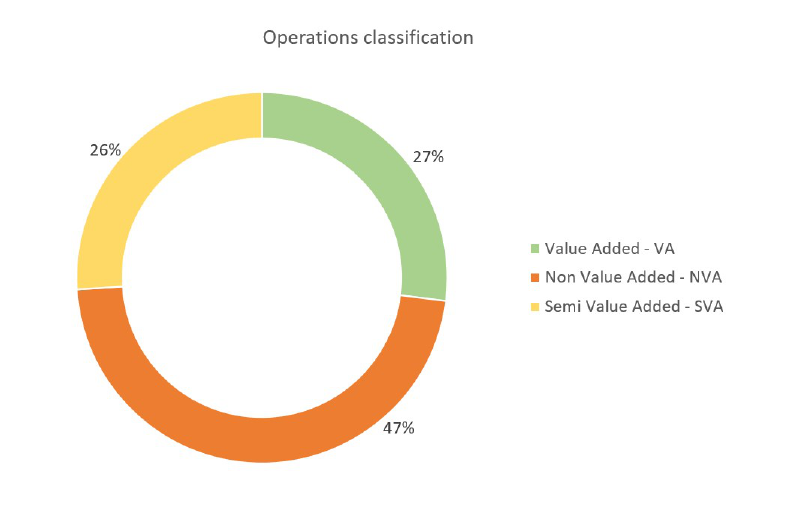
Figure 6. Operation classification in NVA, SVA, and VA of all the areas under examination.